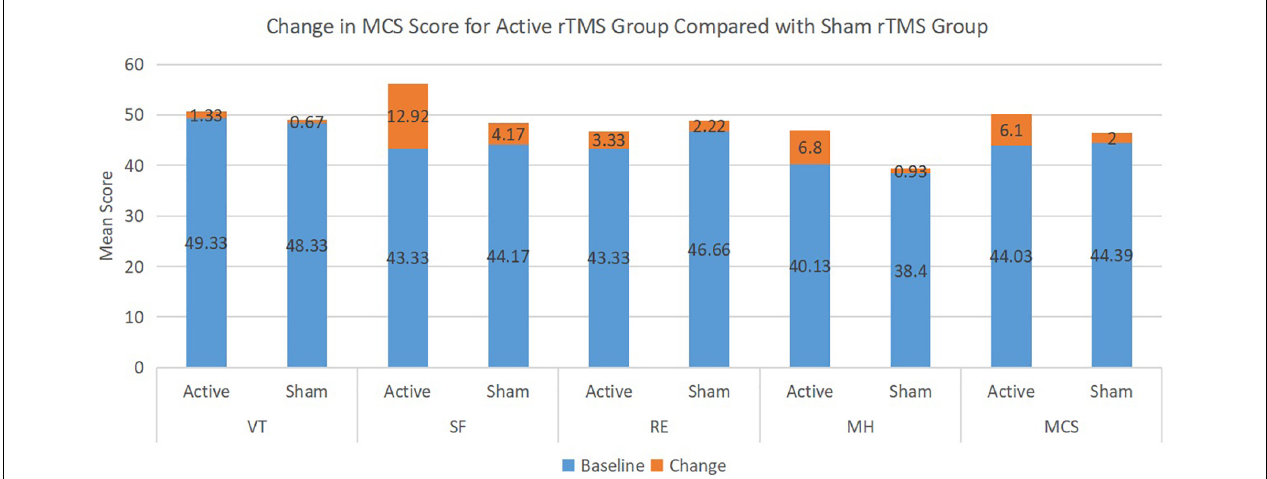
TABLE 4 | Change in drinking pattern in relation to changes in clinical outcomes following treatment.